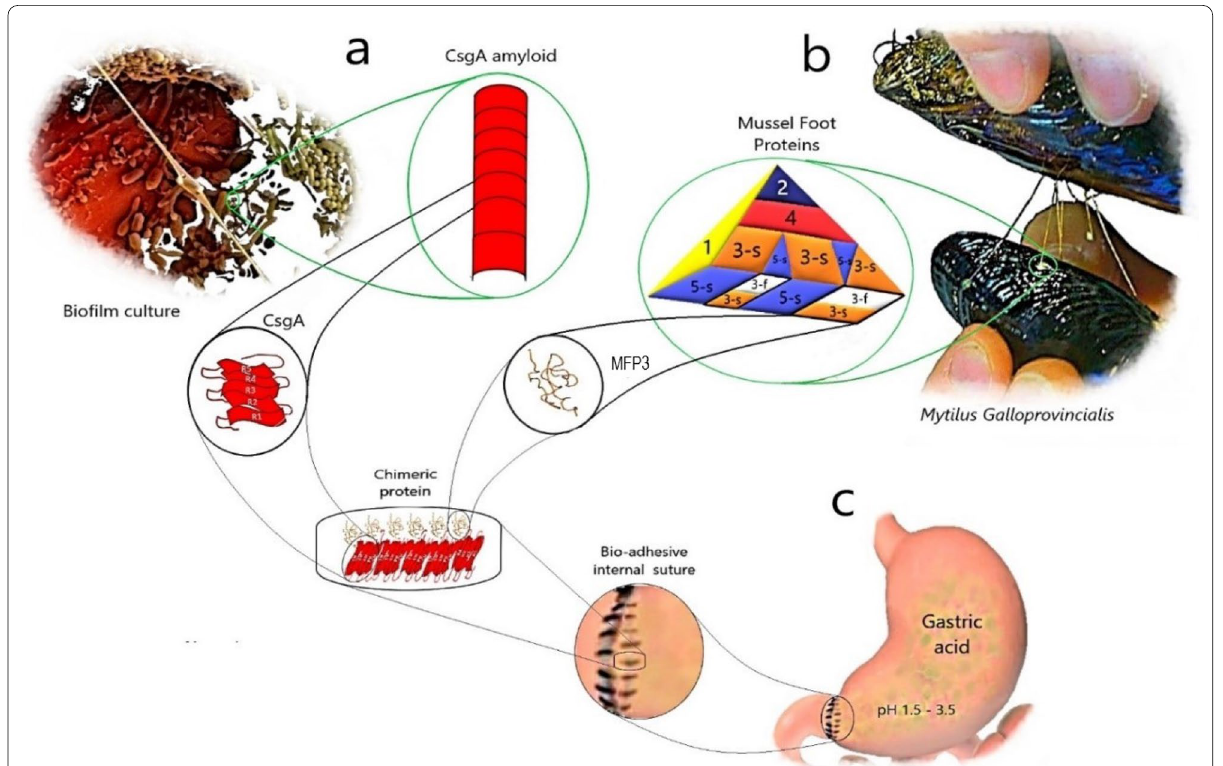
Fig. 1 a A micrograph of mixed-culture biofilm. The secreted CsgA amyloid fibres allow the E. coli cells to collect to adhere to the surface. b M.g mussel and foot proteins distribution by number. MFP1 is already present in the outer layer as a lateral cover. MFP3 (s), MFP3 (f) and MFP5 (s) are shown at the plaque-substratum interface. The presence of MFP3 in both the substrate and the underlying layer considered it a good indicator to analyze its structure. b A suture with a bio-adhesive character on the gastric duodenum. The proteinous bio-adhesive construction, while making the connection between two sections, can maintain its biocompatible activity under the acidic conditions of the